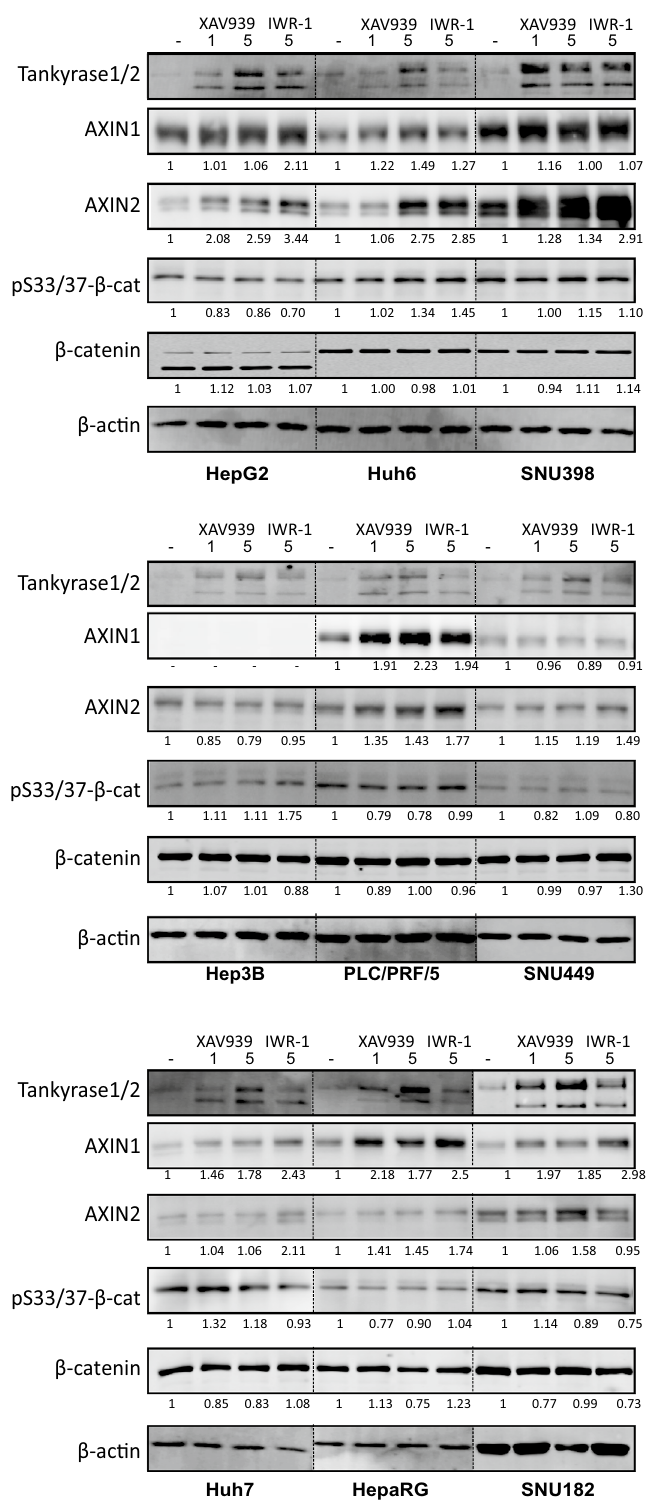
Figure 3. Effect of tankyrase inhibition on indicated proteins. Western blotting assay showing levels of tankyrase-1/2, AXIN1/2, p33/37-β-catenin (pS33/37-β-cat) and total β-catenin after 1-5 μM XAV939 or 5 μM IWR-1 for 24 h. Tankyrase-1/2 efficiently accumulate in all cell lines, while variable responses are observed for AXIN1 and AXIN2. No clear change is observed in pS33/37-β-catenin except for Huh6 and Hep3B, in which a modest increase is seen. Total β-catenin levels are not clearly